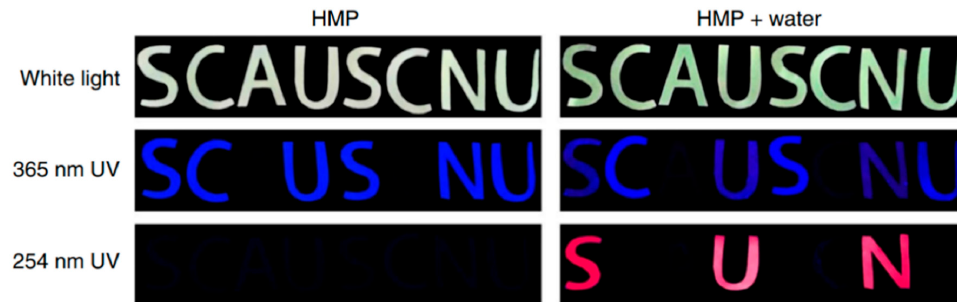
Figure 11. Proof-of-concept security feature made by applying hydrophobic C-dots via marker pen, with and without the addition of water and illuminated under different kinds of light. Reproduced from reference [31], Nature Communications; published by Nature Research, 2019.